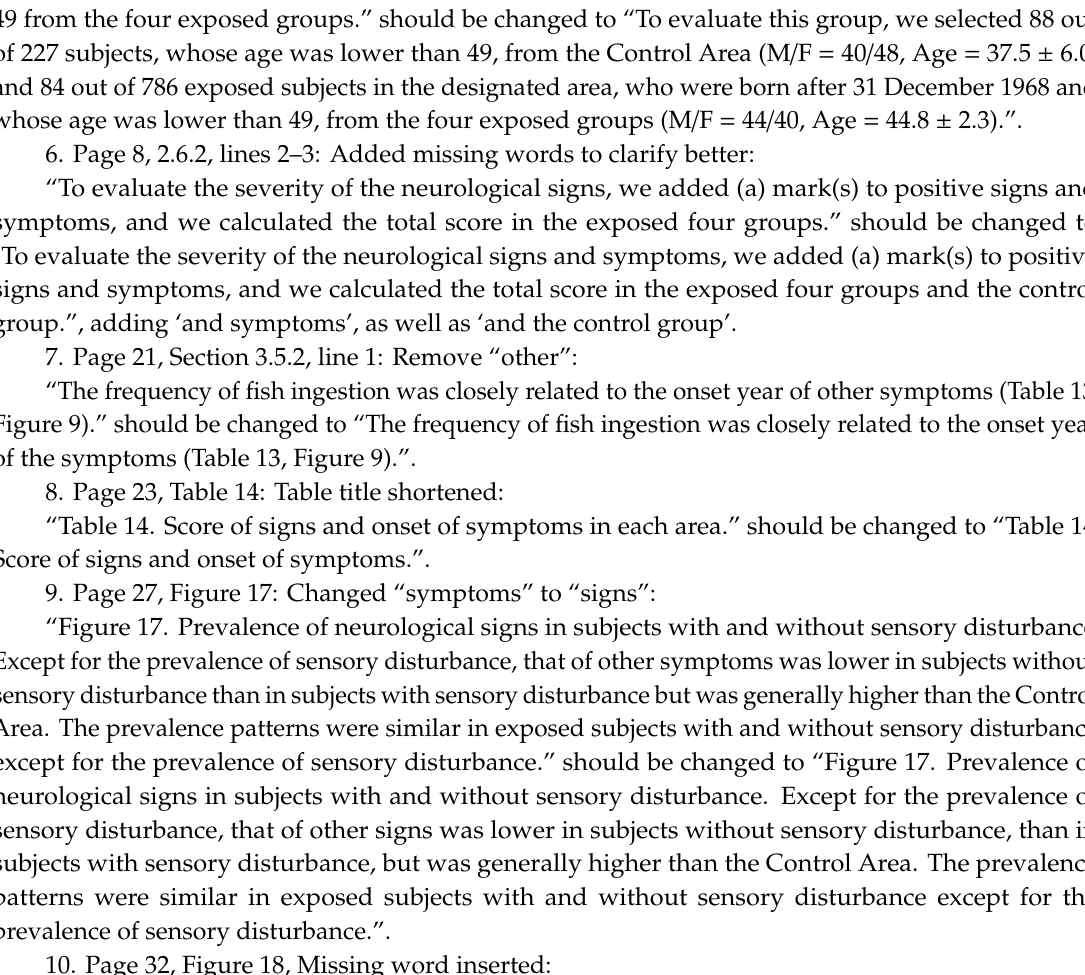
“Figure 17. Prevalence of neurological signs in subjects with and without sensory